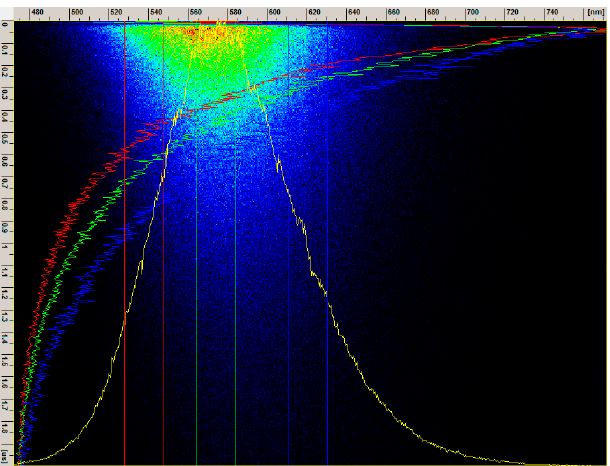
Figure 11. Time resolved luminescence spectra of Ca 0.8 Si 9.6 Al 2.4 O 0.8 N 15.2 :Eu 2+ (4 mol %) excited with 330 nm at pressure 10 kbar. The red, green, and blue region are the spectral windows used to acquire decay profiles at the short wavelength, peak wavelength, and long wavelength region of the spectrum, respectively.